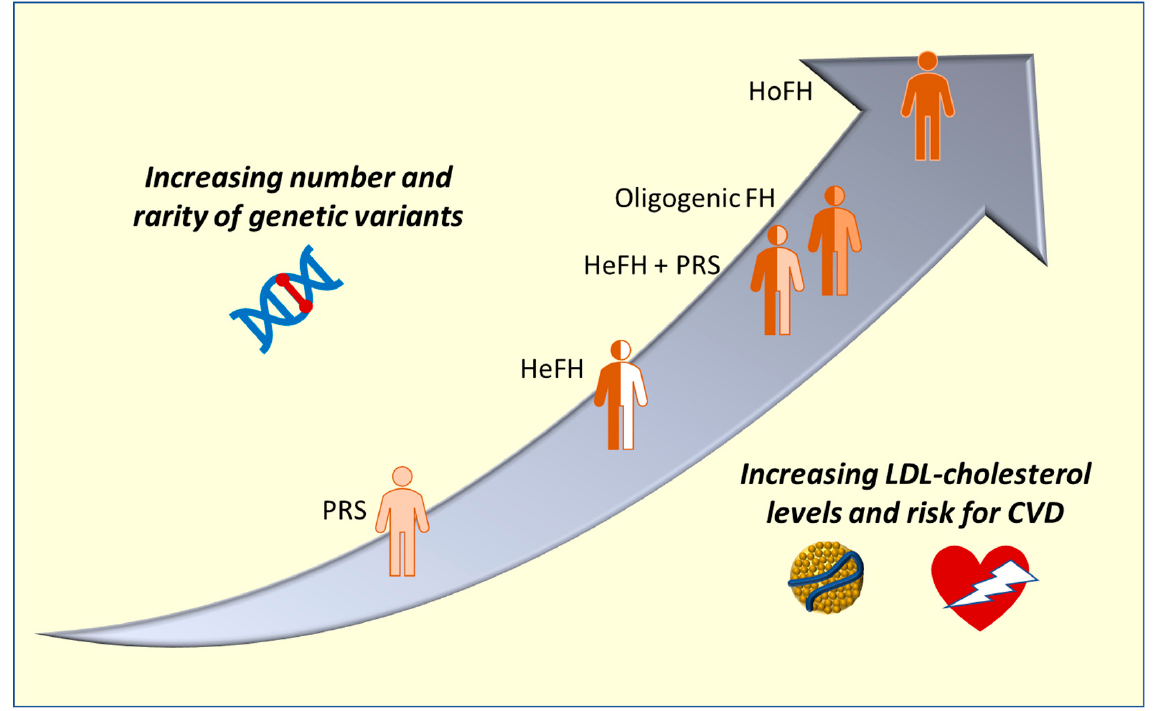
Figure 1. Different genetic status at the basis of hypercholesterolemia and relation with phenotype. The y-axis indicates the number of rare genetic variants, whereas the x-axis indicates the increase in LDL-cholesterol and the associated CVD risk. PRS: Polygenic risk score; HeFH: heterozygous Familial hypercholesterolemia (FH); HoFH: homozygous FH; CVD: cardiovascular disease.